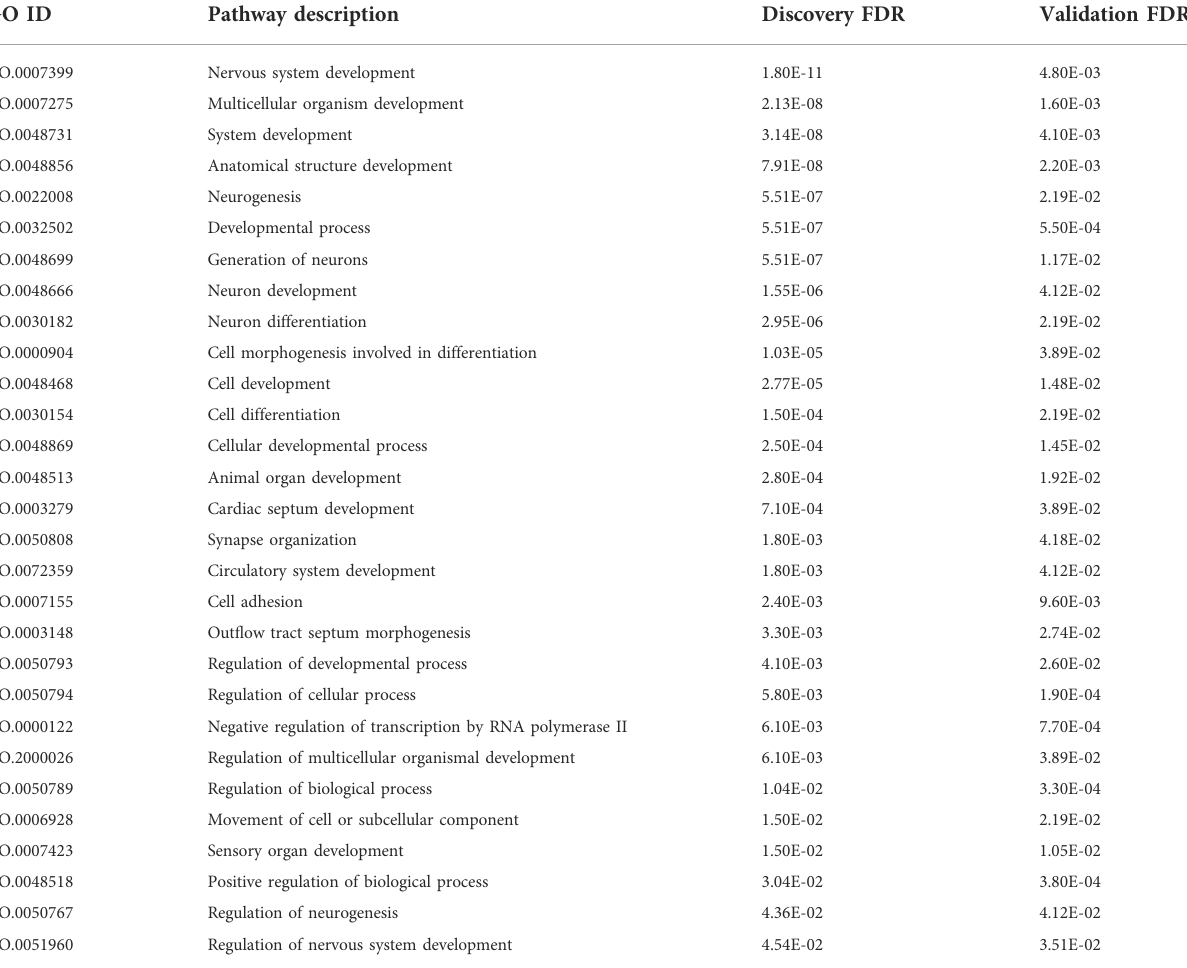
TABLE 1 Gene ontologyterms enriched among DDE DMR-associated genes from discovery and validation cohorts as revealed by STRING analysesof each data set. GO